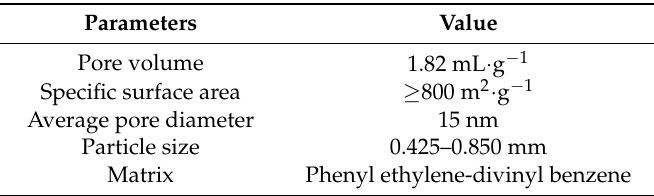
Table 1. Physical characteristics of XAD-16HP